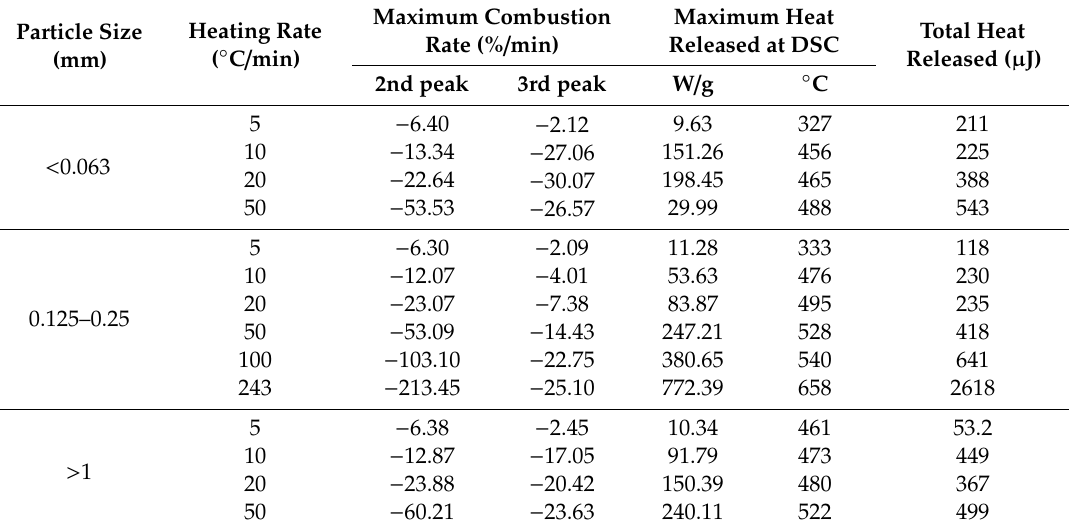
Table 3. Characteristic parameters obtained from the DTG and heat flow